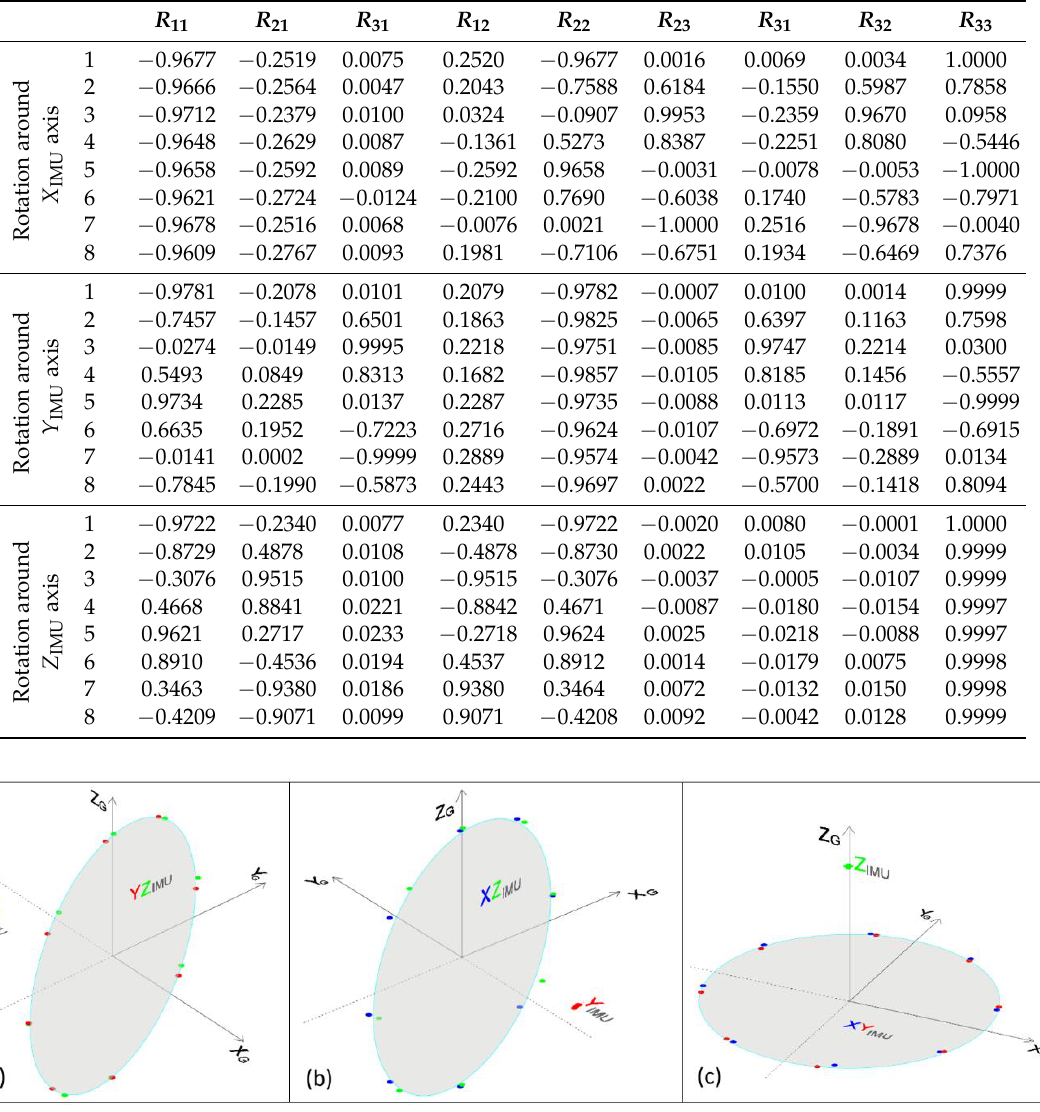
Table 3. Elements of the rotation matrix (unity values) of the inertial measurement unit (IMU) axes when rotated 360 ◦ around its axes.